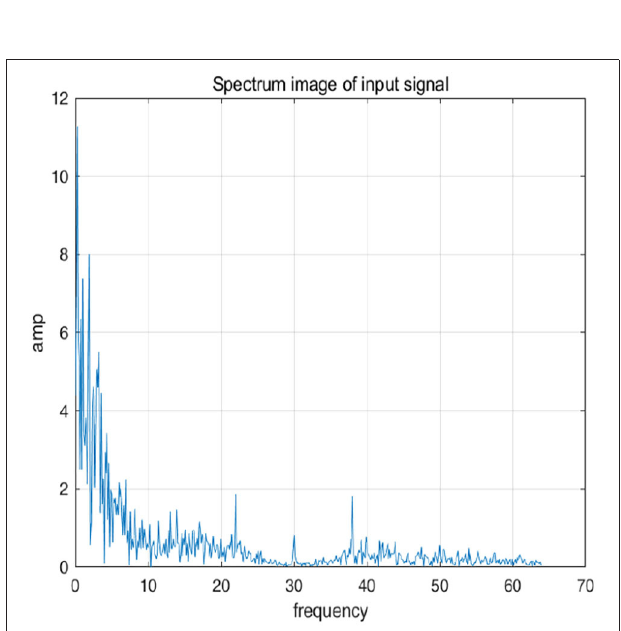
FIGURE 10 | Frequency-domain image of signal in inter-ictal is shown in figure.